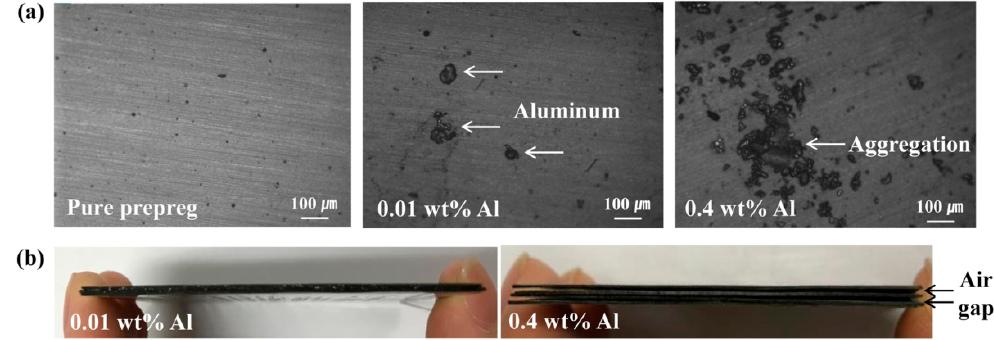
Figure 3. ( a ) Optical microscopy (OM) images of CFRP prepregs: pure prepreg and prepregs coated with aluminum; ( b ) Vertical view of CFRP composites coated with aluminum.